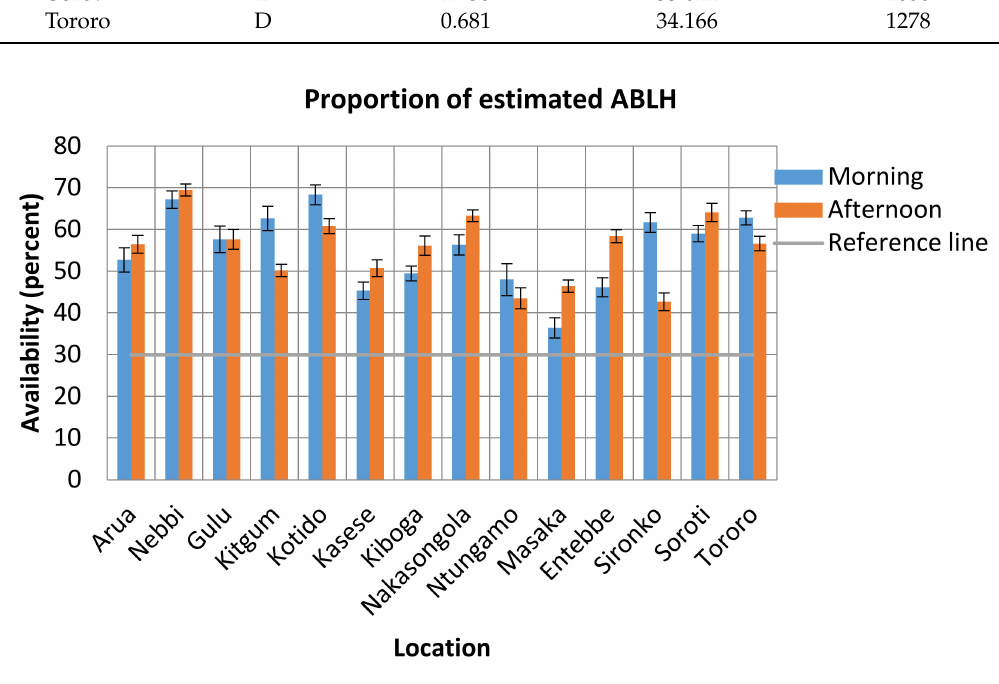
Figure A1. Spatial variations in the availability of estimated ABLH. The reference line represents a fraction below which observations would be deemed too few for statistical